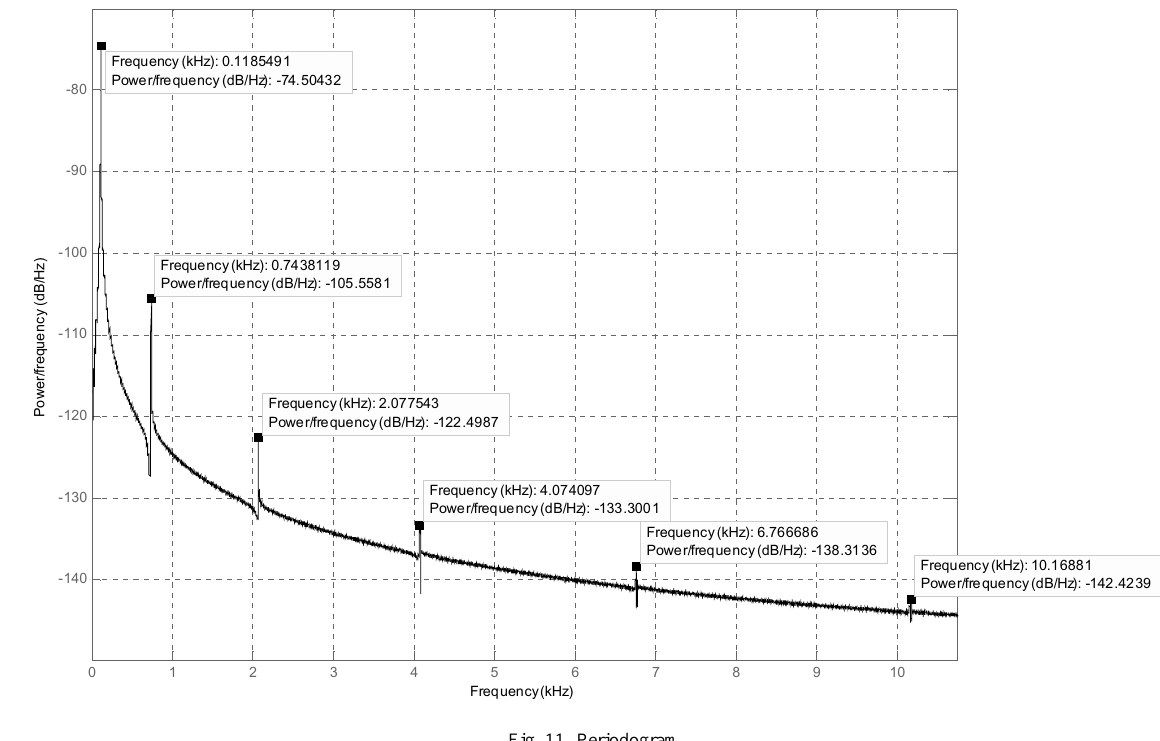
Fig. 11. Periodogram.